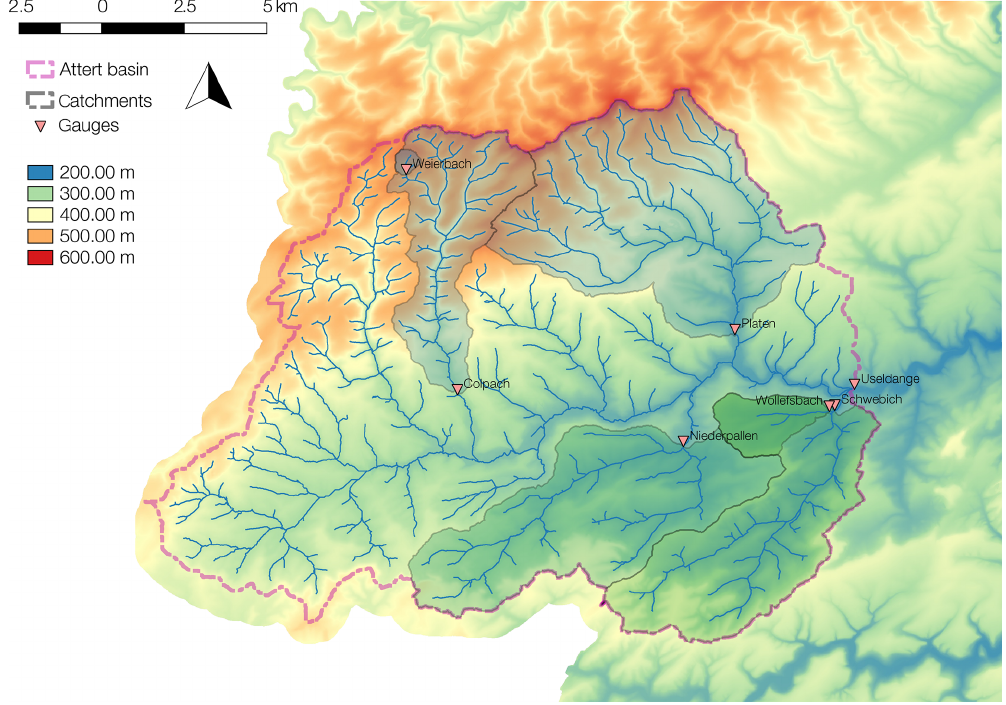
Figure 1. Map of the Attert basin with the six selected headwater catchments. In the northern part of the Attert catchment, the three schist- dominated catchments (blue; Platen, Colpach and Weierbach) are highlighted, and in the southern part, the three marl-dominated catchments are highlighted (green; Schwebich, Niederpallen and